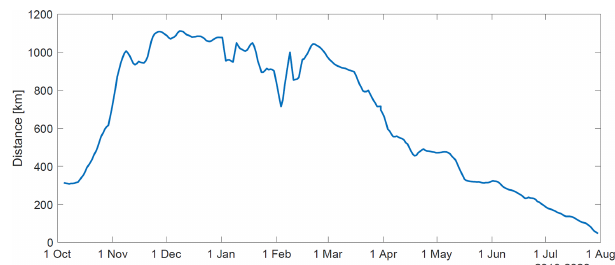
Figure 11. Distance of the MOSAiC CO to the ice edge obtained from the sea ice concentration data